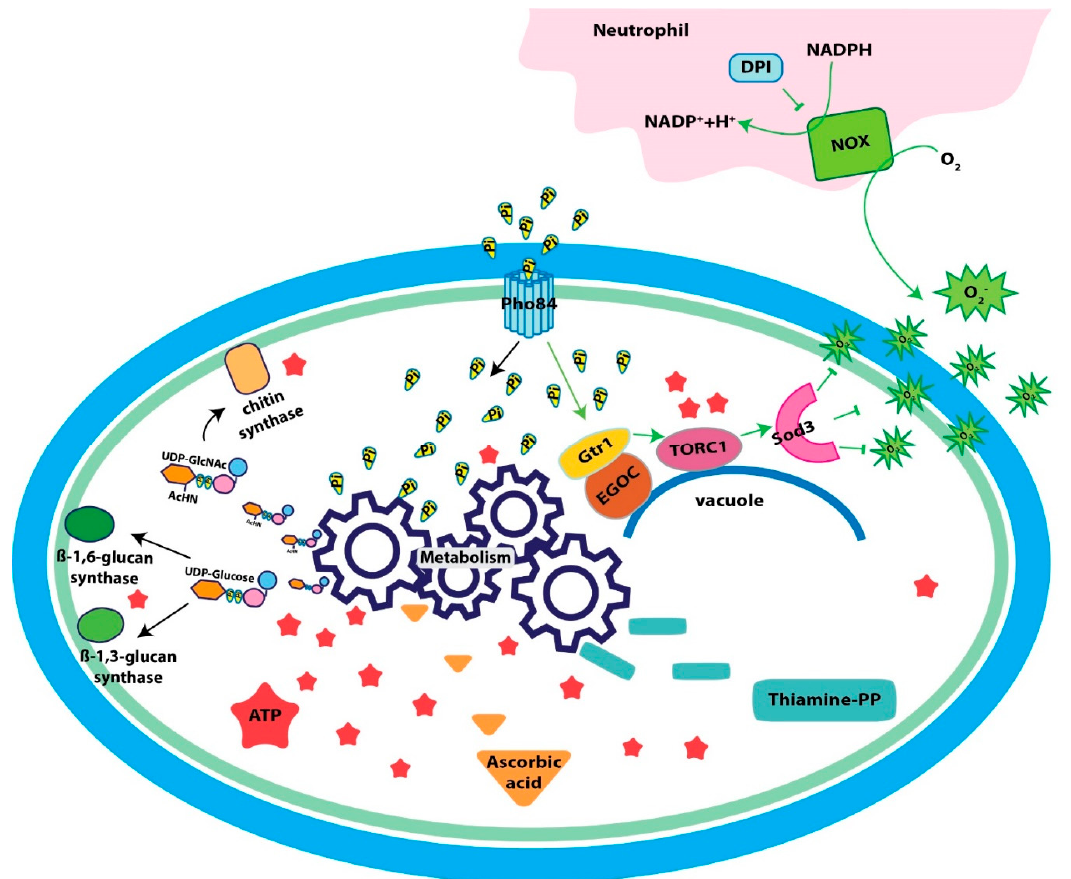
Figure 2. Model: Pho84 contributes to C. albicans TORC1 signaling, metabolism, cell wall integrity and oxidative stress defense. The high-affinity inorganic phosphate (Pi) transporter Pho84 plays a significant role in cellular import of Pi. Cytosolic and mitochondrial Pi becomes available to metabolic processes that produce substrates for cell wall construction enzymes (nucleotide sugars UDP-glucose and UDP-N-Acetylglucosamine, GlcNAc), the energy currency ATP, and co-factors with possible